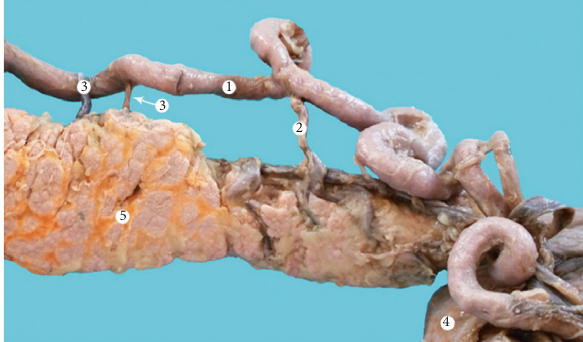
Figure 4: Type II vascular supply of the pancreas (dissection). 1: splenic artery; 2: dorsal pancreatic artery; 3: short branches of the splenic artery; 4: spleen; and 5: pancreas.